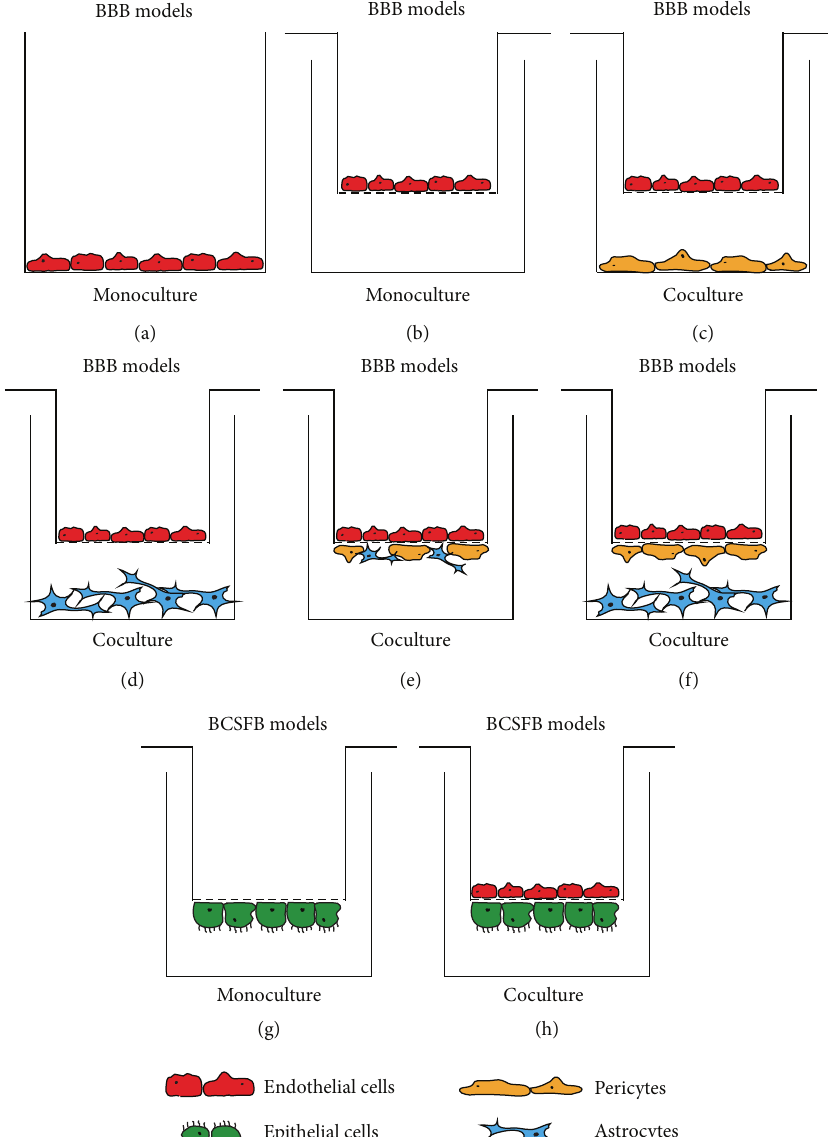
Figure 2: Schematic representation of various in vitro BBB and BCSFB models. The BBB models are built up around endothelial cells, whereas the BCSFB models rely on epithelial cell culture. The setup can be a monoculture: endothelial or epithelial cells only (a, b, and g); coculture: endothelial cells with epithelial cells (h) or endothelial cells with pericytes or astrocytes (c and d); and triple-culture: endothelial in combination with astrocytes and pericytes (e and f). These systems can be set up in a “contact” (e, f, and h) or “noncontact” (c and d) manner (“contact”: different cell types have physical contact with each other; “noncontact”: different cell types were not able to physically interact with each other). The monoculture models represented in (a) and (b) can also be used with epithelial cells instead of endothelial cells. The addition of chemical mediators (cytokines and/or chemokines) and virus or immune cells (T-, B-cells, and PMNs, etc.) is possible in both the filter insert and/or